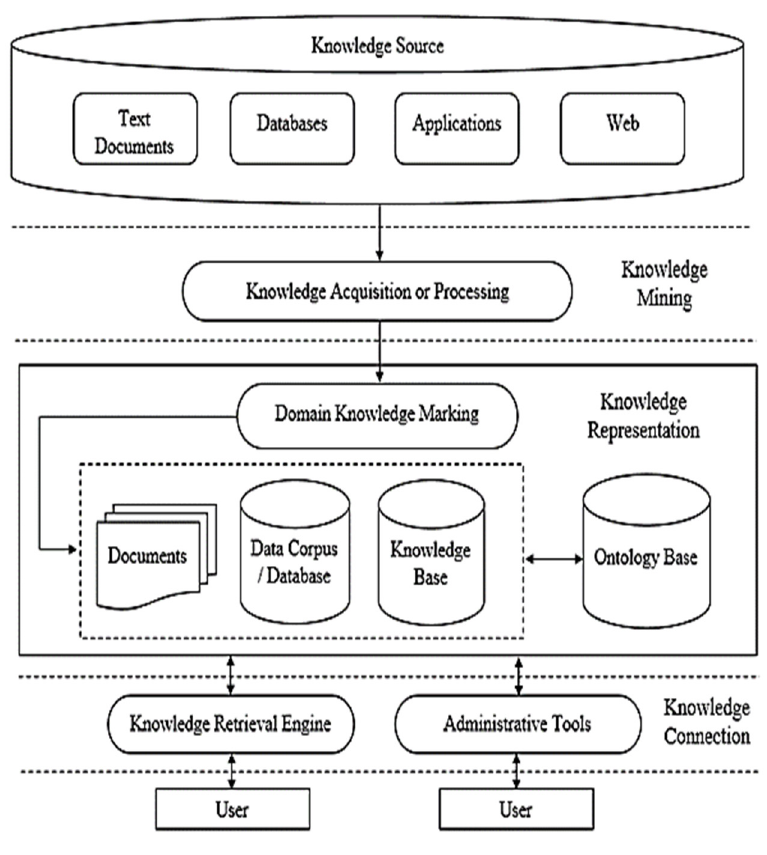
Figure 1. Ontology-based structured knowledge management system.